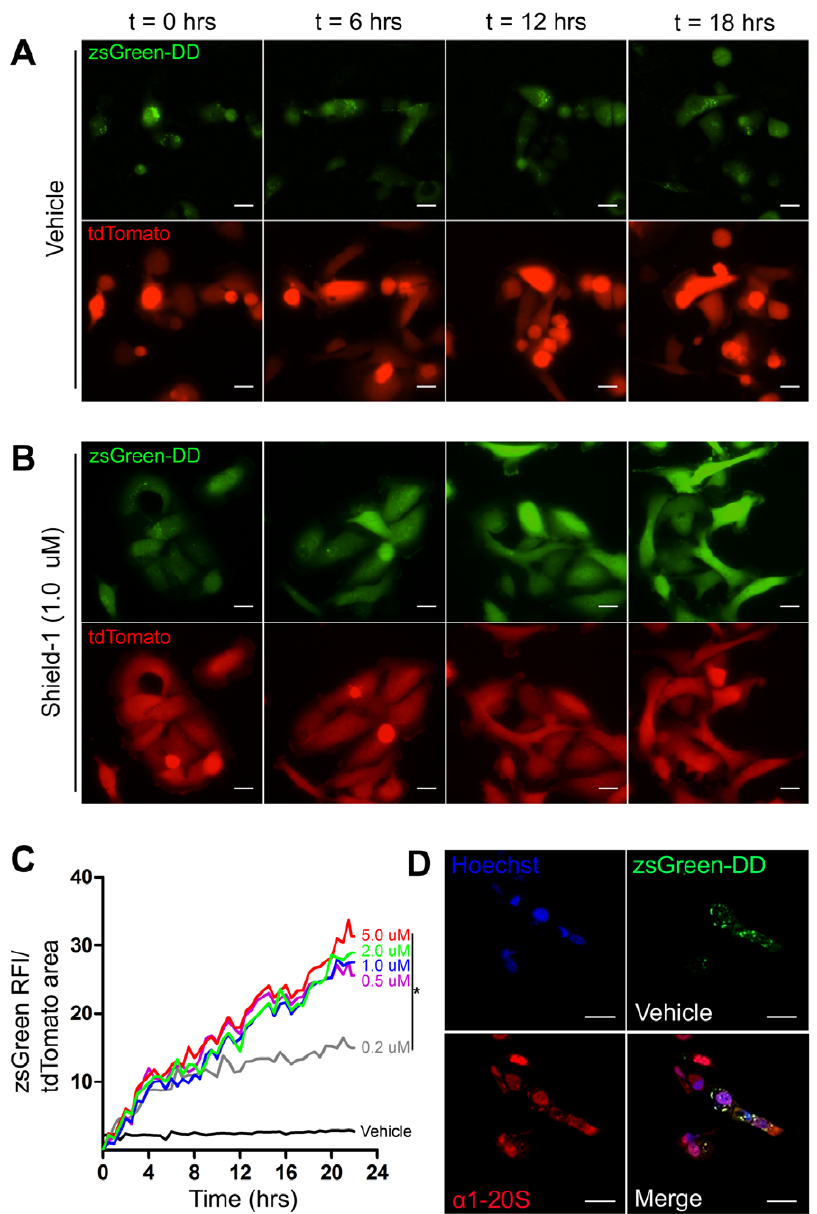
Figure 2. Rapid induction of the fluorescent protein zsGreen in MDA-MB-231LN (231LN) cells invitro . 231LN cells containing both tdTomato and zsGreen-DD were grown on glass coverslips. Panels represent fluorescence time-lapse imaging of 231LN cells treated with vehicle (A) and 1.0 m M of Shield (B). C) Quantification of zsGreen signal within the cells in the presence and absence of Shield-1 over time (*denotes p , 0.01 compared to Vehicle treatment kinetic, N . 10 cells per field of view, 10 fields of view analyzed per group). Treatment with 0.5, 1.0 and 2.0 m M Shield-1 revealed similar first order kinetics, while treatment with 0.2 m M Shield-1 revealed a similarly steep but brief increase (induction) in signal accumulation followed by a less steep kinetic at 4 hours post-treatment (depletion kinetic). D) Fluorescence immunohistochemistry demonstrates co- localization of proteasome ( a 1-20S antibody in red) with zsGreen-DD signal in 231LN cells in the absence of Shield-1. All scale bars are 25 m m.